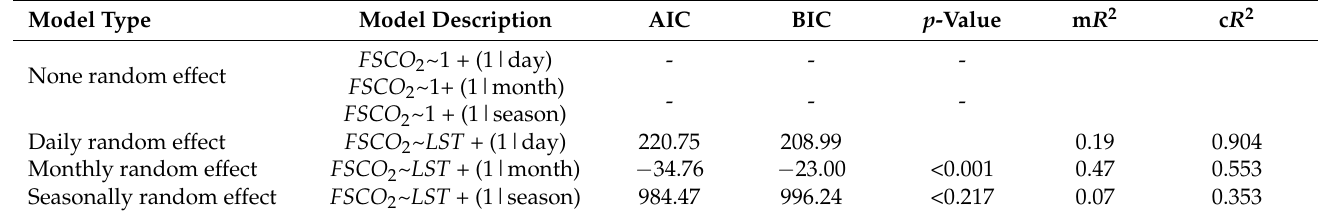
Table 2. Evaluation of linear mixed effect models, outlined by random intercept and Fusion LST November, December, and January), and season (Autumn, Winter and Dry) of the year. Models were assessed using the Akaike information criterion (AIC), Bayesian information criterion (BIC), the p -value of a chi-squared test, and both marginal and conditional R -squared (m R 2 and c R 2